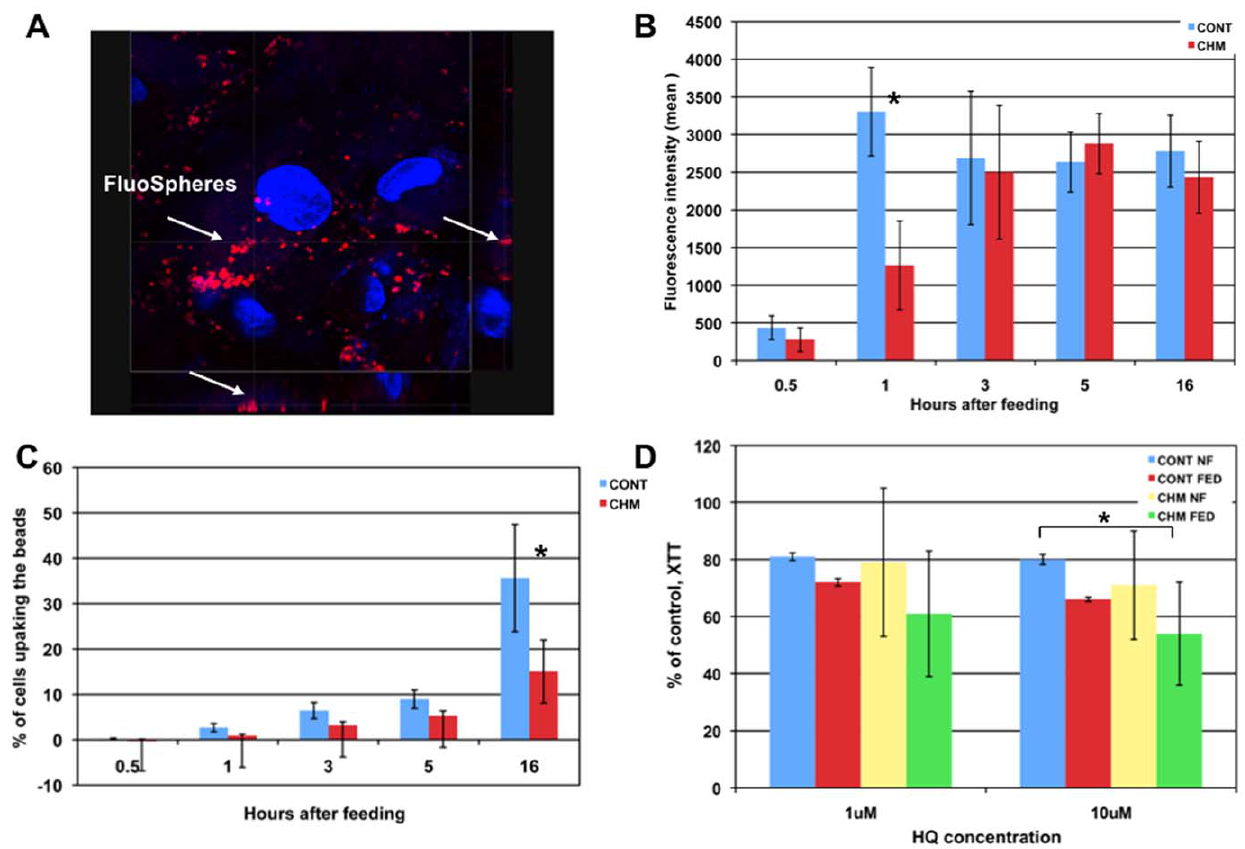
Figure 6. Differential uptake of collagen coated beads (FluoSphere) by primary fibroblasts from CHM and control patients. a. Confocal image of the fibroblasts 1 h after the uptake of collagen coated fluorescent beads. Note that beads were internalized into the cytoplasm. b. Rates of bead uptake 1 h following feeding was significantly higher in the control cells (n=7) compared to the CHM patients (n=6) as measured by flow cytometry. Data expressed as mean fluorescence intensity + / 2 SED at 1, 3, 5 and 16 h. After that CHM cells demonstrated a similar rate of the uptake. c. Percent of cells taking up beads was consistently higher in the control cells (16 h period). d. CHM fibroblasts (n=5) cultures fed with beads less resistant to the oxidative stress initiated by the treatment with 1 m M and 10 m M of hydroquinone (HQ) when compared to controls (n=3). Viability levels were measured using XTT and expressed as percent viability of non-treated non-fed cells.